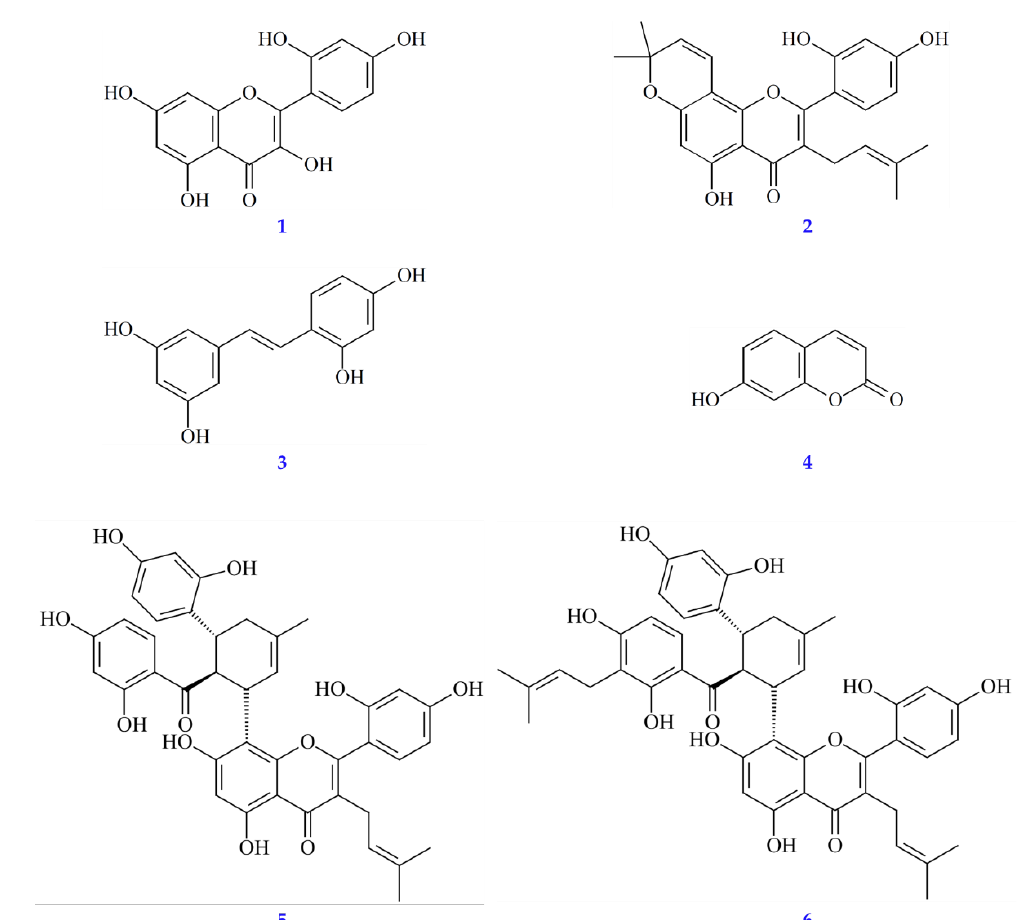
Figure 2. Chemical structures of morin ( 1 ), morusin ( 2 ), oxyresveratrol ( 3 ), umbelliferone ( 4 ), kuwanon G ( 5 ), and kuwanon H ( 6 ) from Morus alba.